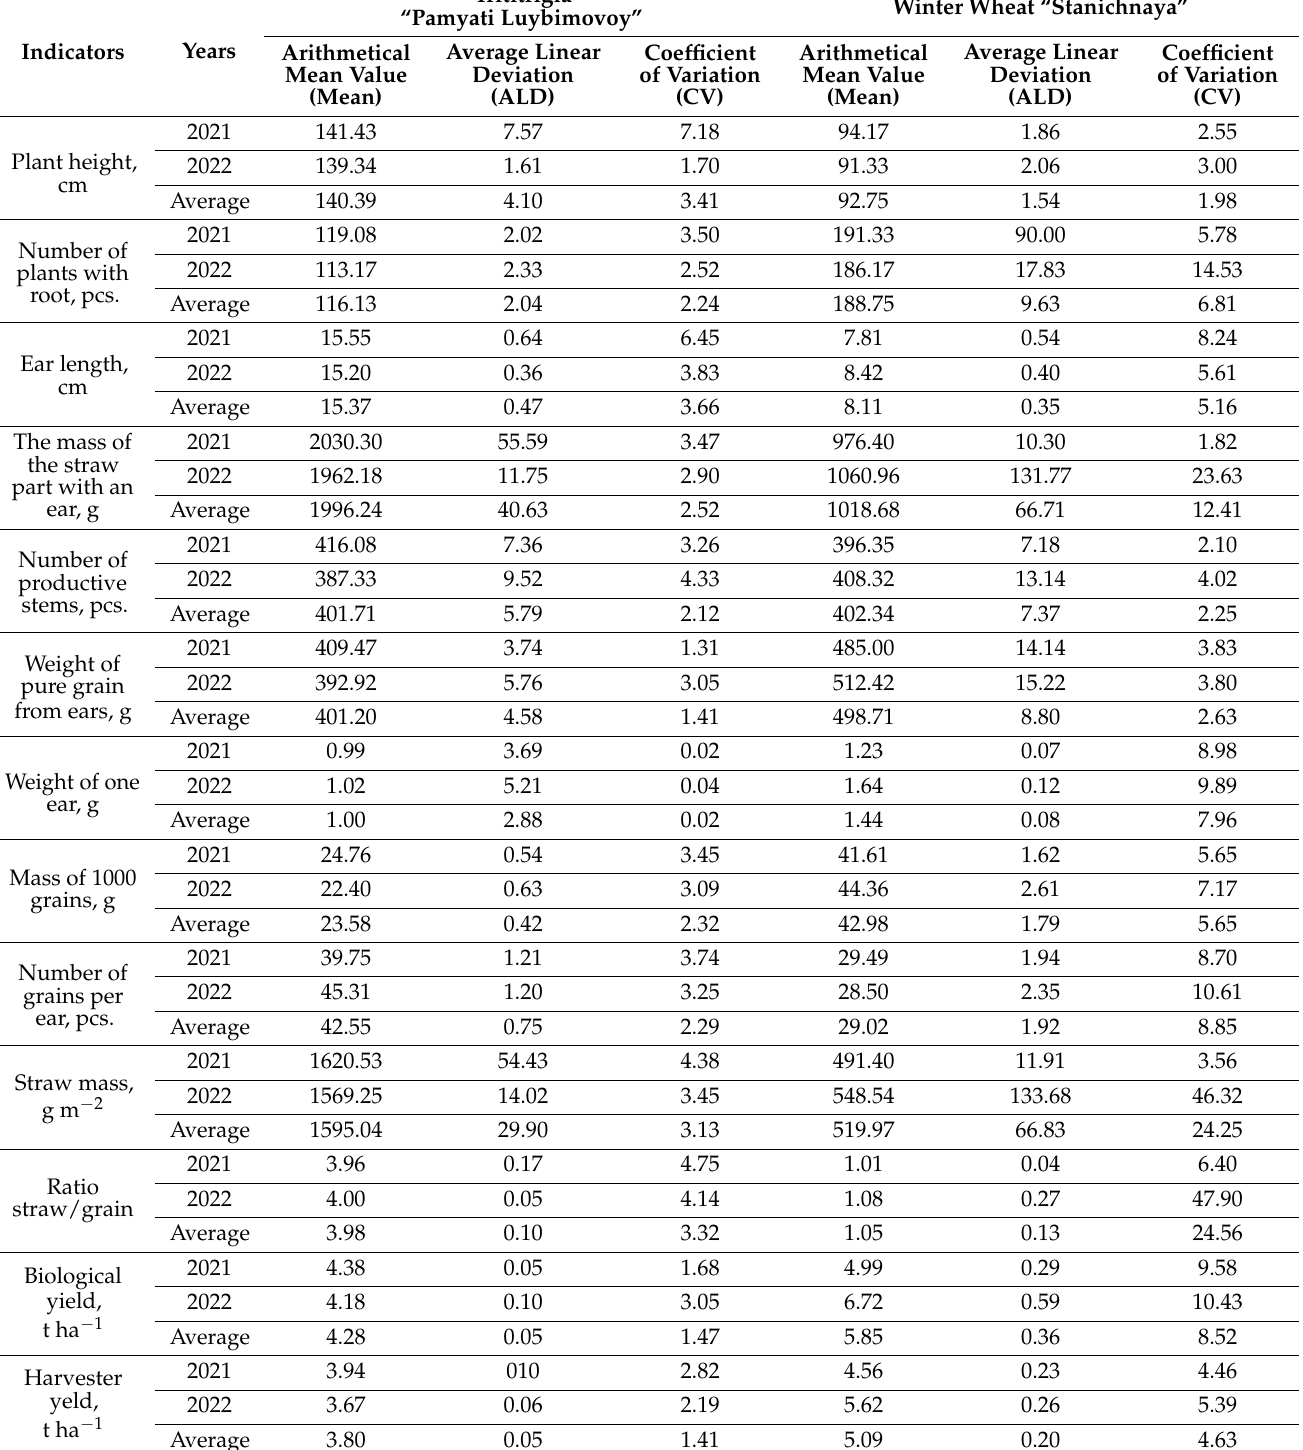
Table 2. Trititrigia and winter wheat crop structure